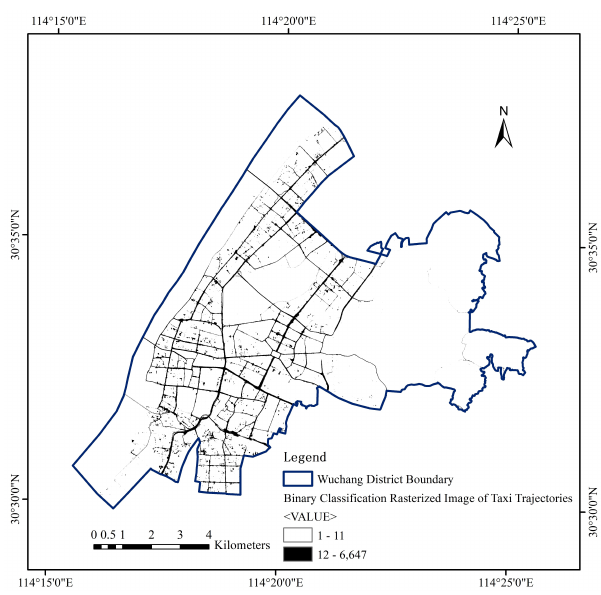
Figure 5. Binary classification rasterized image of taxi trajectories (Zhang,